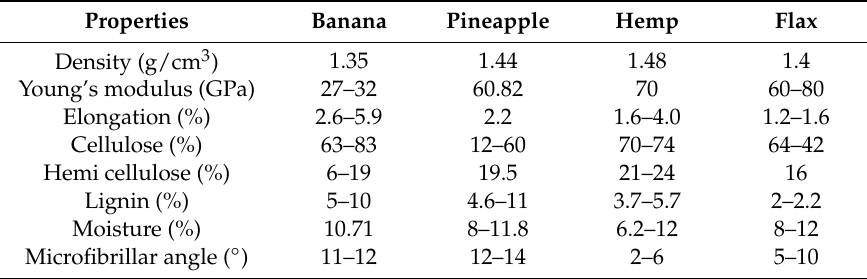
Table 1. The chemical and mechanical properties of natural fibers [29,30].